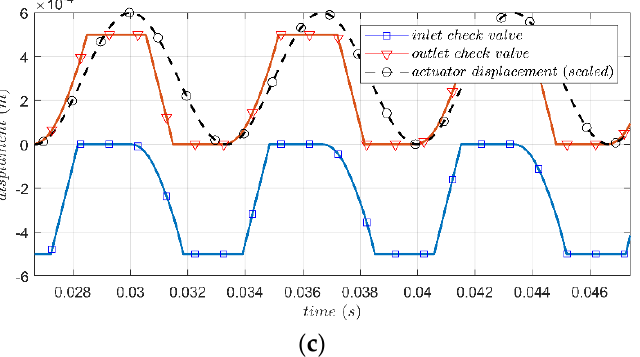
Figure 9. The displacement of check valves at several driving frequencies. ( a ) Driving frequency: 10 Hz. ( b ) Driving frequency: 120 Hz. ( c ) Driving frequency: 150 Hz.